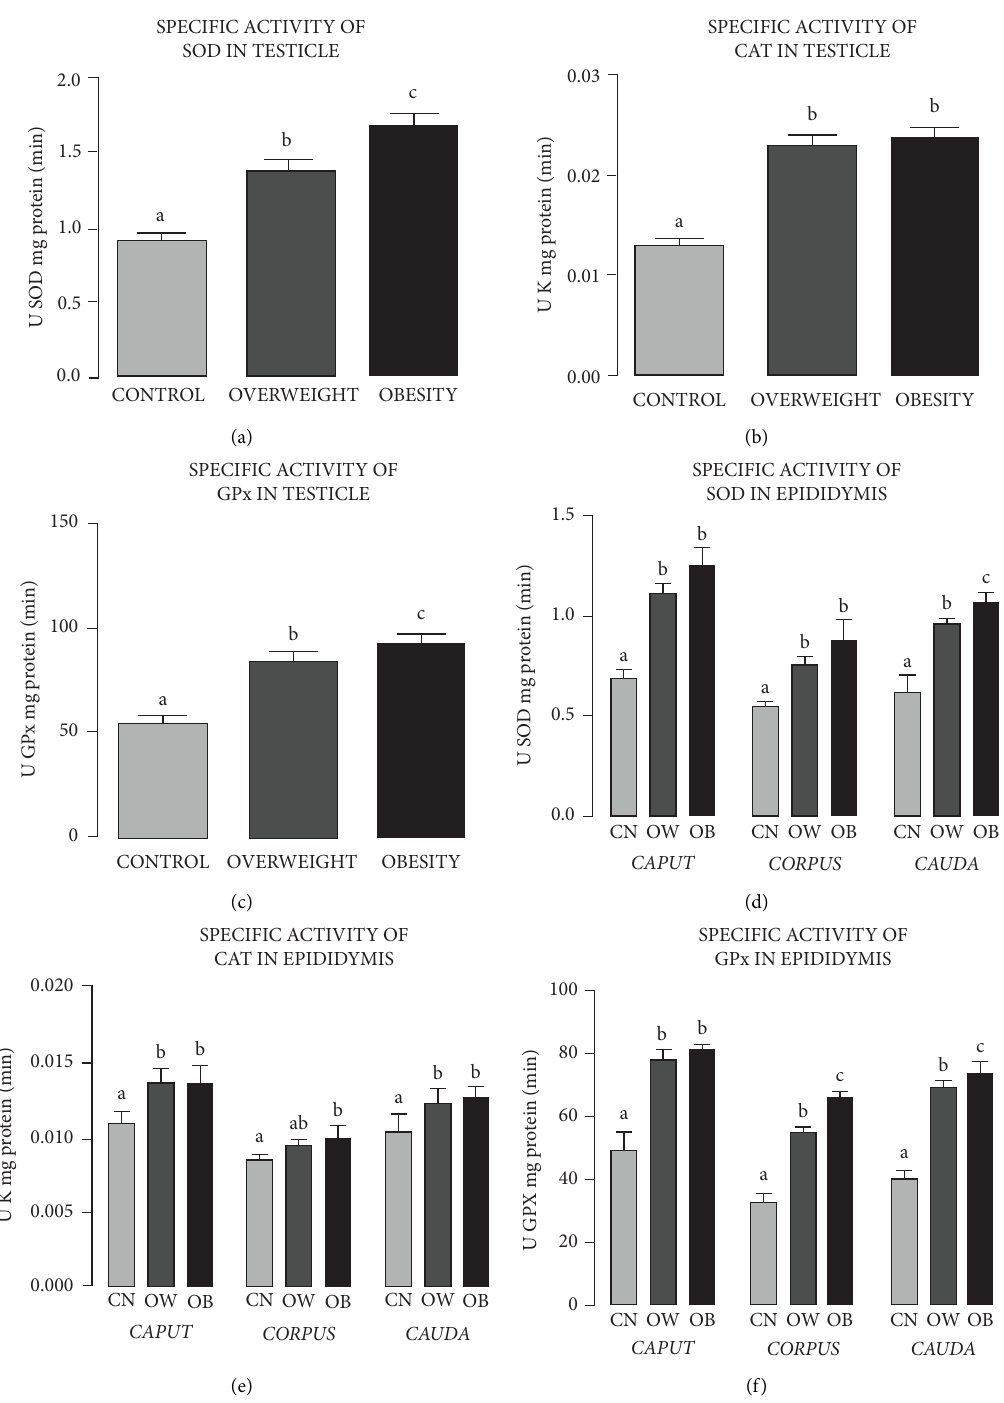
Figure 3: Specific activity (SA) of the antioxidant enzymes superoxide dismutase (SOD), catalase (CAT), and glutathione peroxidase (GPX) in the testes and epididymides of Wistar rats fed with regular chow (control (CN)) or hyperlipidemic diets with 10% or 60% fat (the overweight (OW) and obesity (OB) groups), respectively. Specific activity is expressed in mg of protein/min. Letters indicate significant differences between the study groups ( P < 0 . 05) (CN vs. OW vs. OB). Also shown are the SAs of the antioxidant enzymes superoxide dismutase (SOD) (a), catalase (CAT) (b), and glutathione peroxidase (GPX) (c) in the testicles, all presented as mean ±